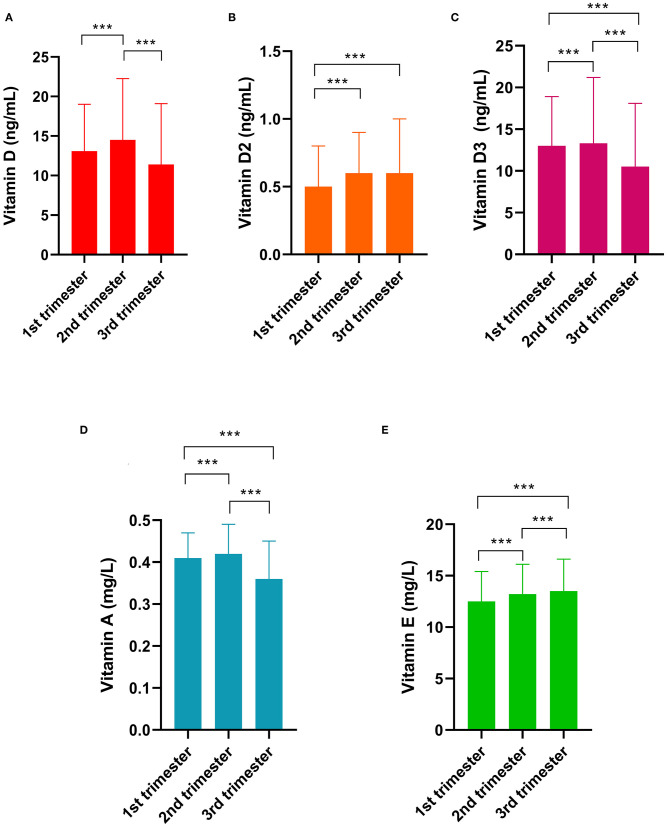
Differences in vitamin levels among the gestational trimesters. (A) Vitamin D; (B) Vitamin D2; (C) Vitamin D3; (D) Vitamin A; (E) Vitamin E. *** indicates p < 0.001.